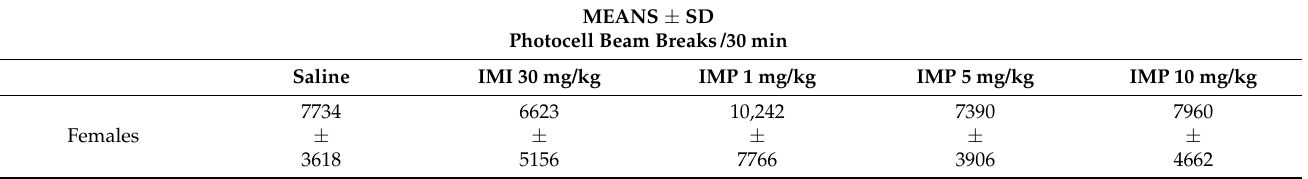
Table 1. Imperatorin (1, 5, and 10 mg/kg) does not affect spontaneous locomotor activity (30 min) in female Swiss mice. Mice were placed in actimeters immediately after saline, imperatorin (IMP 1, 5, and 10 mg/kg, i.p .), or imipramine (IMI 30 mg/kg, i.p .) injections. Data are presented as mean ± SD. n = 8; p < 0.05 vs. saline-treated female control group, one-way ANOVA: Tukey’s test. MEANS ± SD Photocell Beam Breaks/30